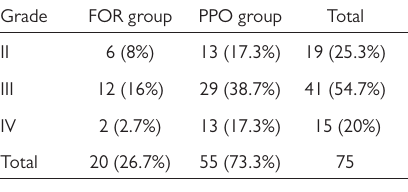
Table 1. Comparison of the FOR group and the PPO group according to the Tonnis classification of patients [11]